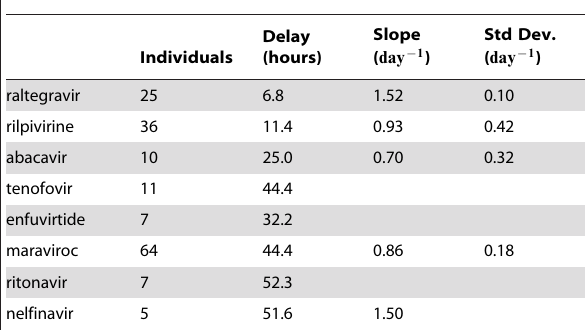
Table 2. Monotherapy data.